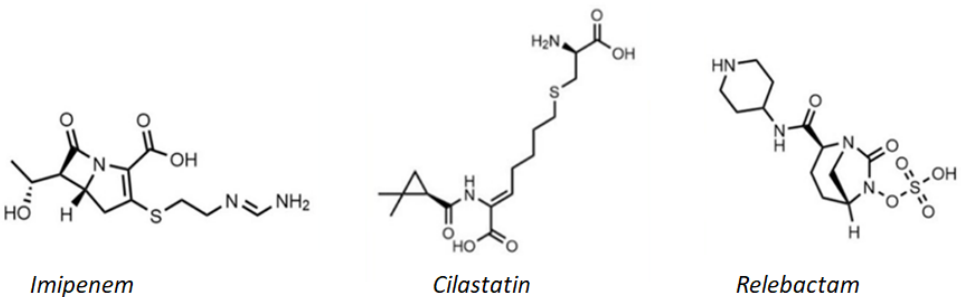
Figure 6. Imipenem/cilastatin/relebactam. Figure 6.